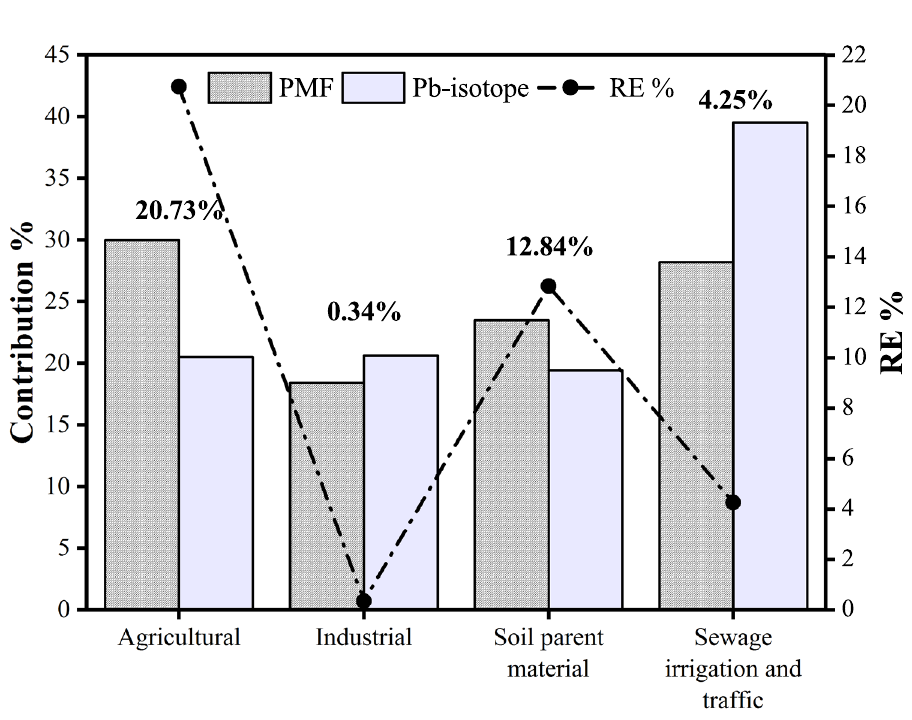
Figure 7. REs between source contribution rates analyzed by PMF and Pb isotope ratio